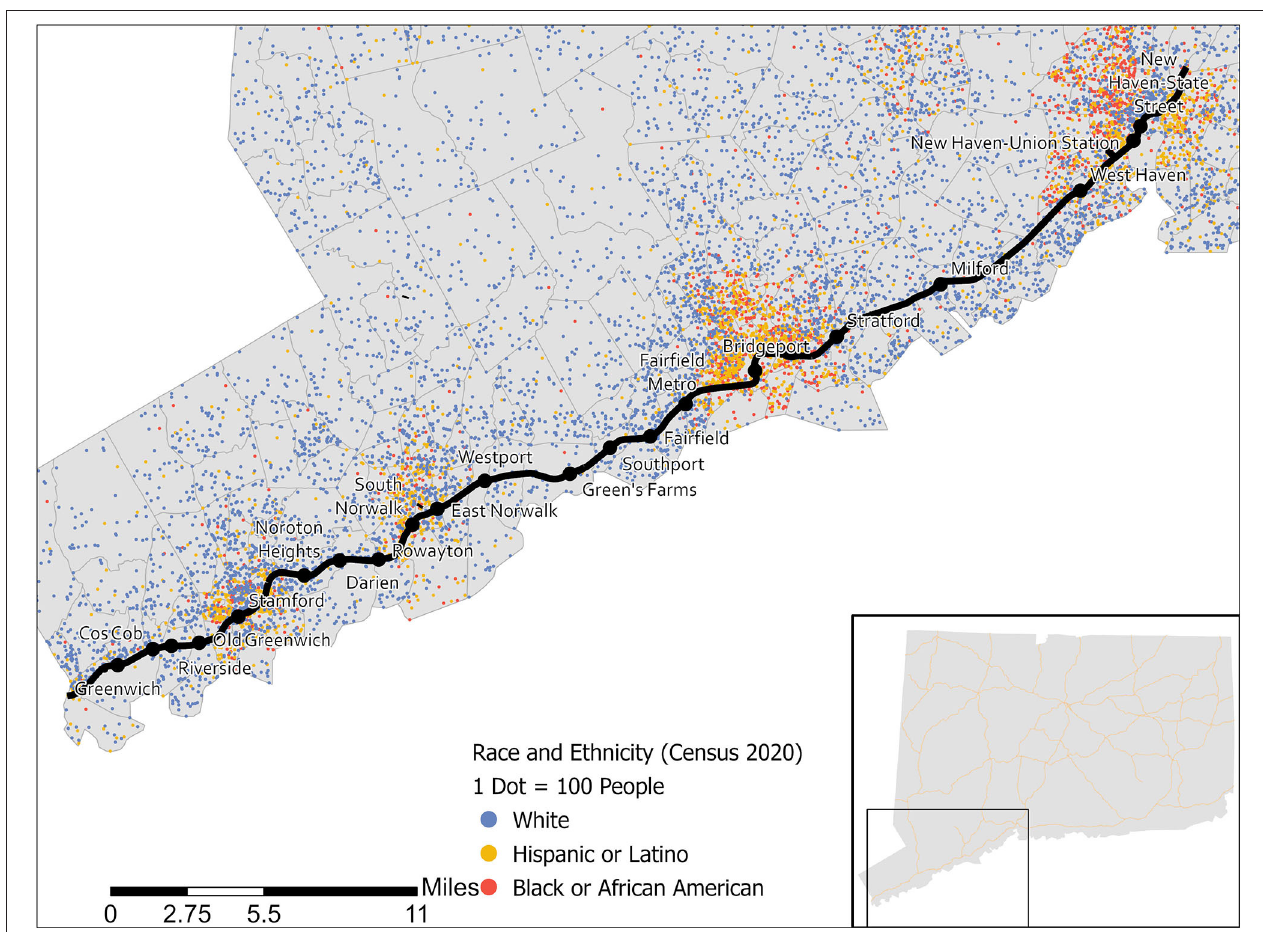
FIGURE 1 | Overview map of the Metro-North New Haven Corridor, showing racial